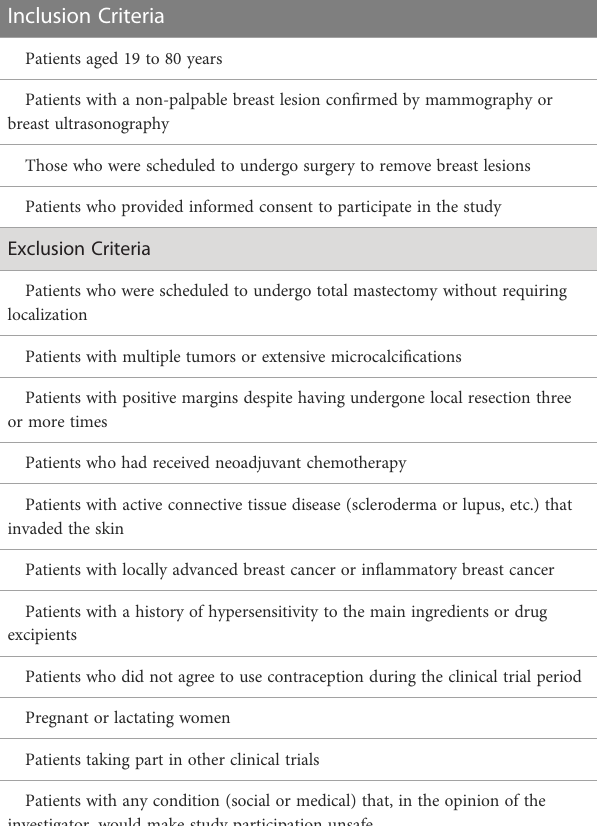
TABLE 1 Inclusion and exclusion